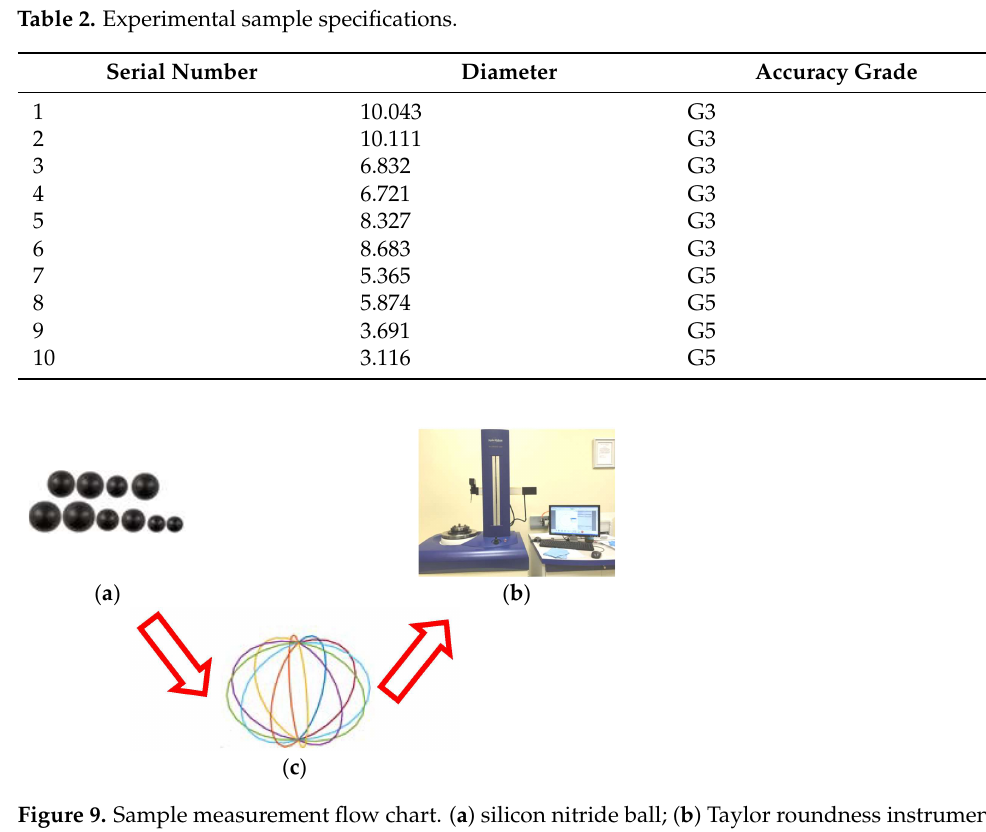
Table 2. Experimental sample specifications. Serial Number